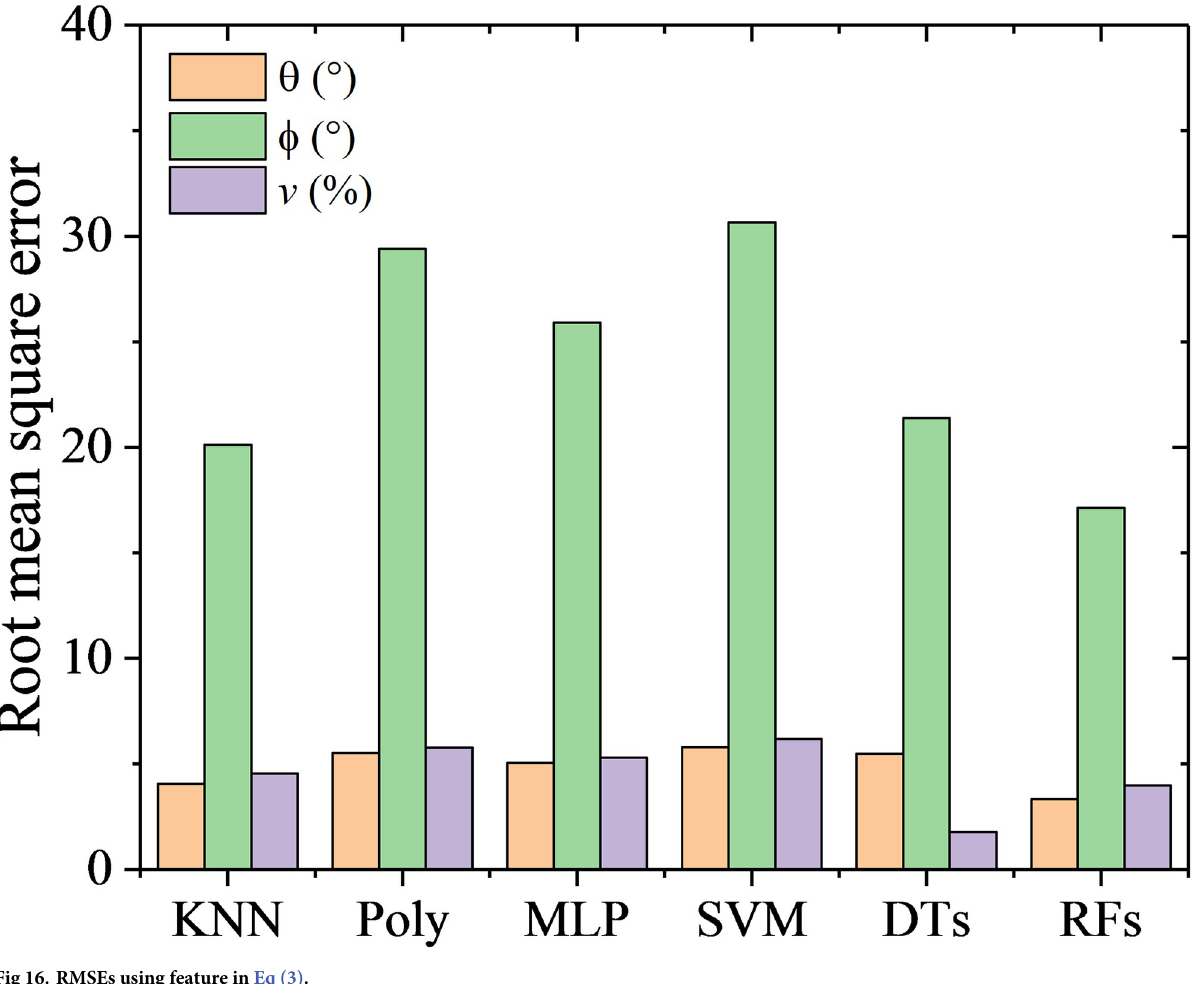
Fig 16. RMSEs using feature in Eq